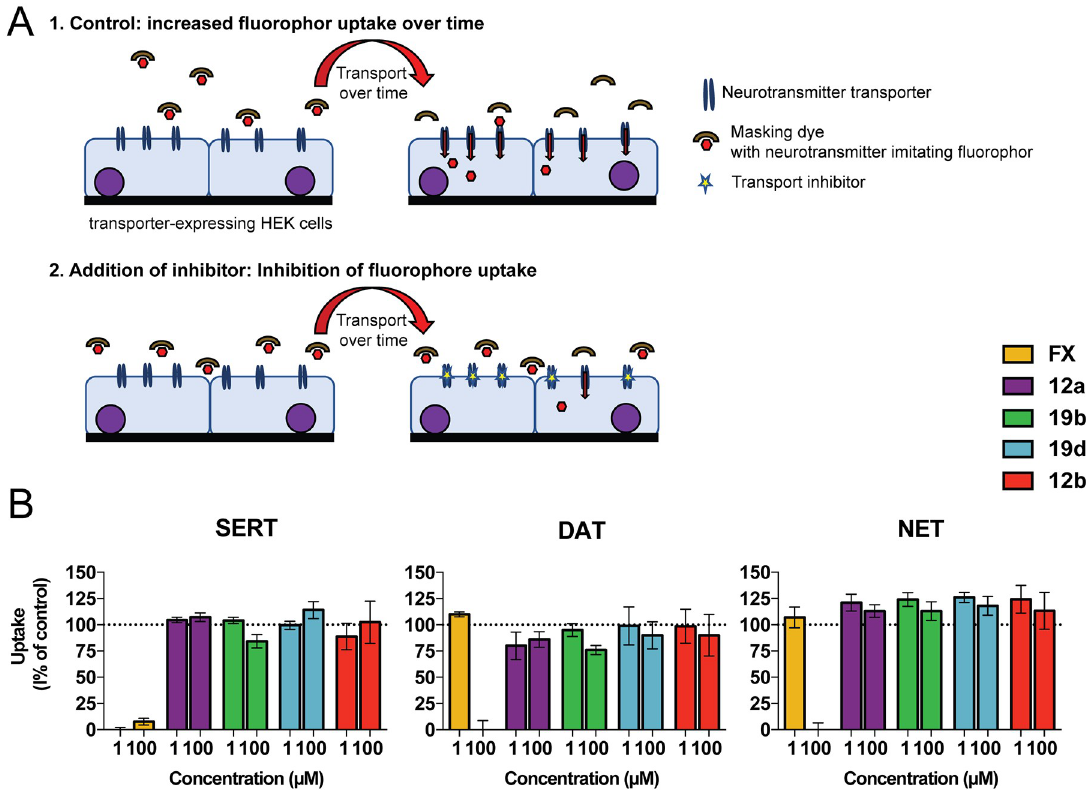
Fig 8. Broadly active EV inhibitors do not affect SERT, DAT, or NET activity. (A) Overview of the principle of the fluorescent measurements of neurotransmitter transporter function. Cells expressing human monoamine transporters (SERT, DAT, or NET) are incubated with a fluorescent transporter substrate and a cell-impermeable masking dye that extinguishes only extracellular fluorescence (left). Cells gain fluorescence following uptake of the substrate, and the increase in fluorescence is a measure for transporter function (top right). Cells with impaired transporter function will take up less substrate, resulting in lower fluorescence (bottom right). (B) Effects of fluoxetine and compounds 12a, 12b, 19b, and 19d on inhibition of SERT-, DAT-, and NET-mediated uptake of fluorescent substrate. Uptake is shown as mean ± SEM as percentage compared to control (DMSO) wells ( n = 7–16 wells, derived from 2 independent cultures). All underlying experimental data that are displayed can be found in S2 Data. DAT, dopamine transporter; EV, enterovirus; FX, racemic fluoxetine; NET, norepinephrine transporter; SERT, serotonin transporter.